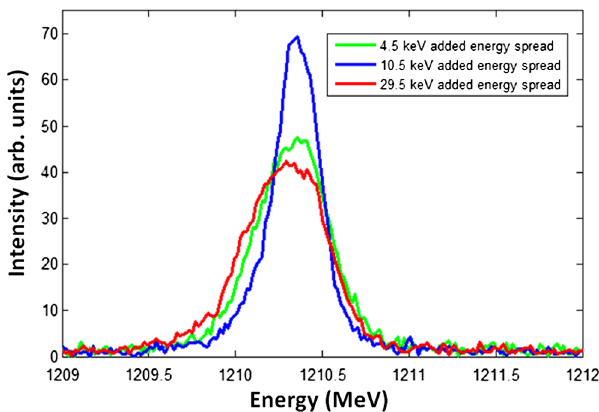
FIG. 14. Energy profiles of a central portion of the beam delimited by the black lines in Fig. 13 for three settings of the laser heater. Note that the measured profile no longer has the hornlike features, indicating a very similar transverse spot size for the laser and the electron beam.